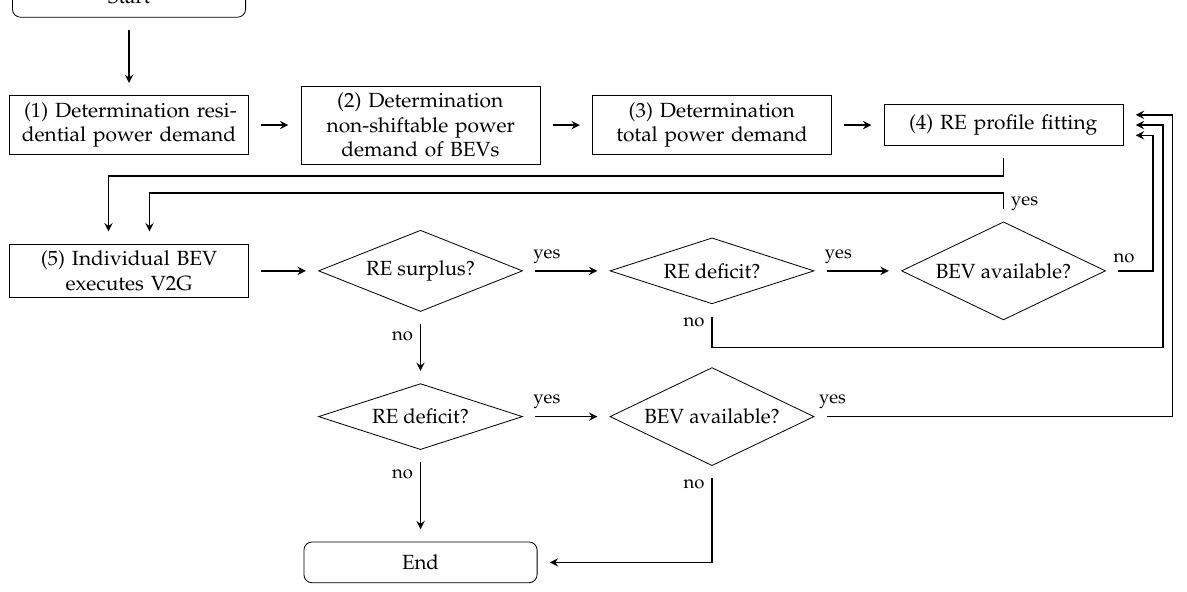
Figure 4. Method for determining the share of residential and BEV power demand coverable by renewables if V2G is